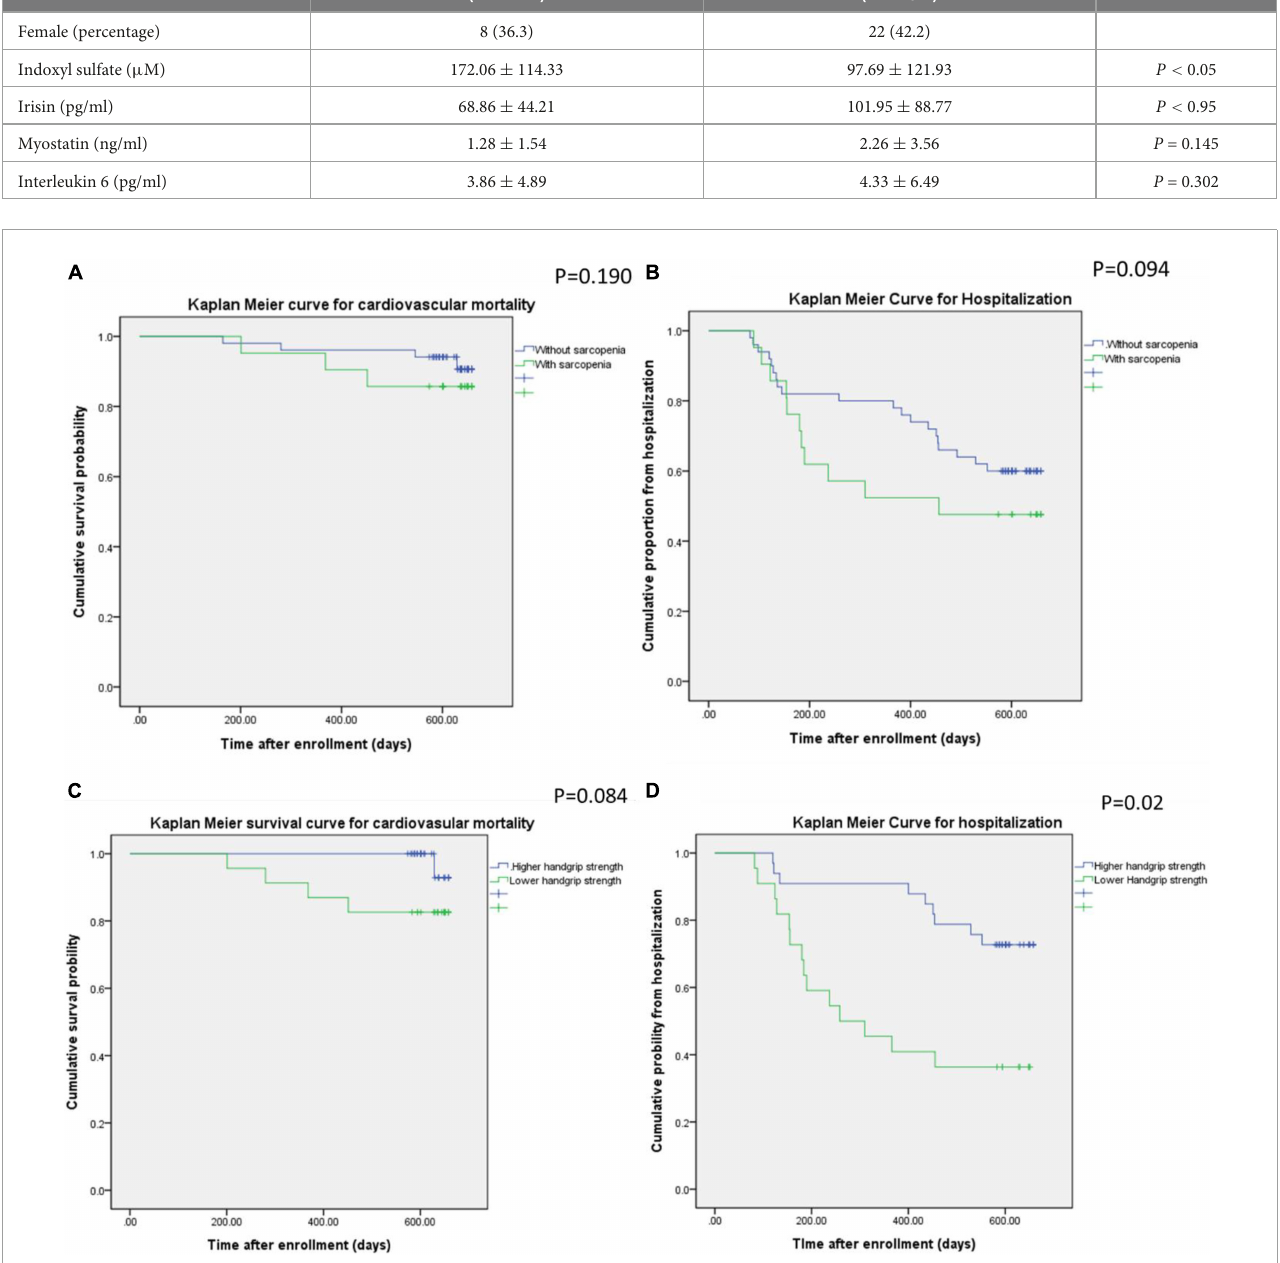
FIGURE1 Kaplan–Meier curves for cardiovascular mortality and hospitalization in the participants with or without sarcopenia (A,B) and low handgrip strength (C,B)